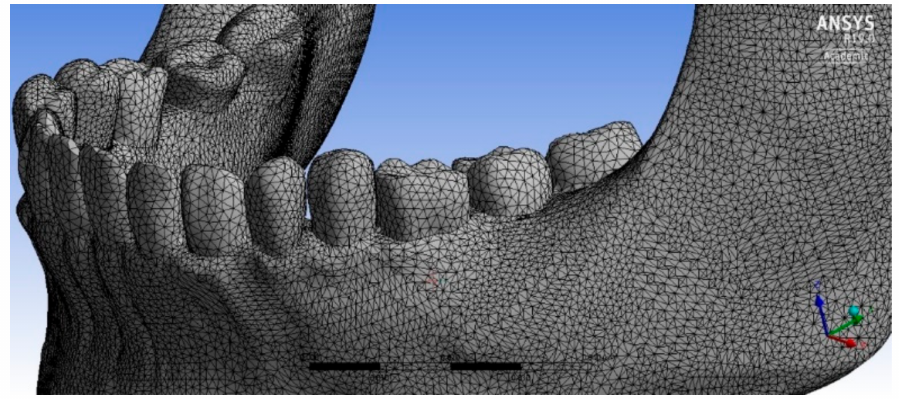
Figure 2. The mandible model’s tetrahedral finite element network.